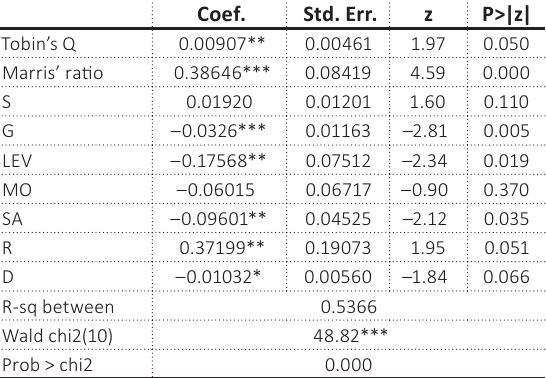
Table 3. Model estimation with random effects